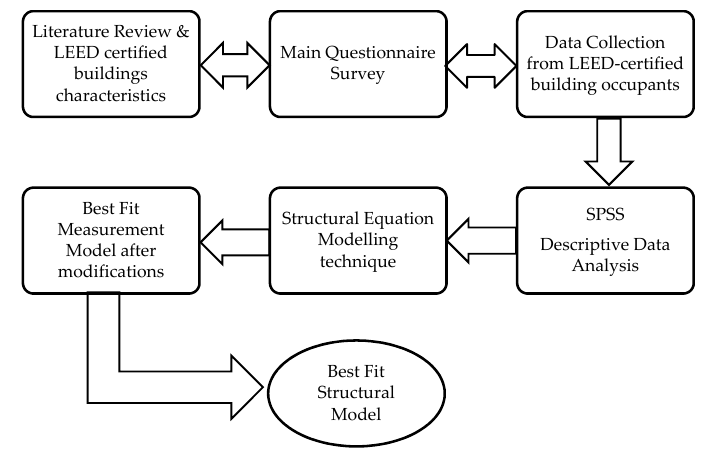
Figure 1. Research design diagram.